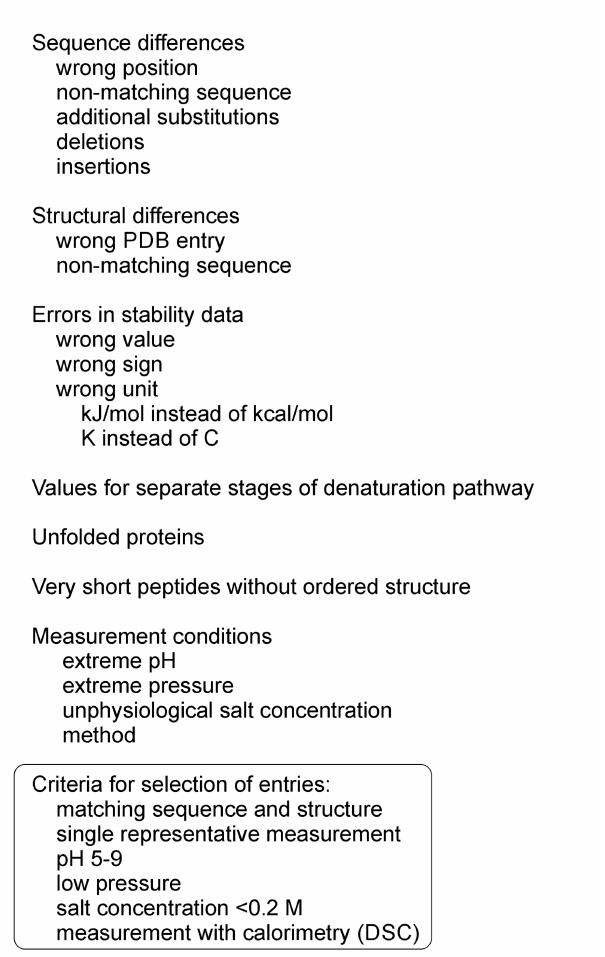
Figure 1. Types of problems and issues noted in ProTherm and which were taken into account when selecting an unbiased dataset for method training and testing. PDB, Protein Data